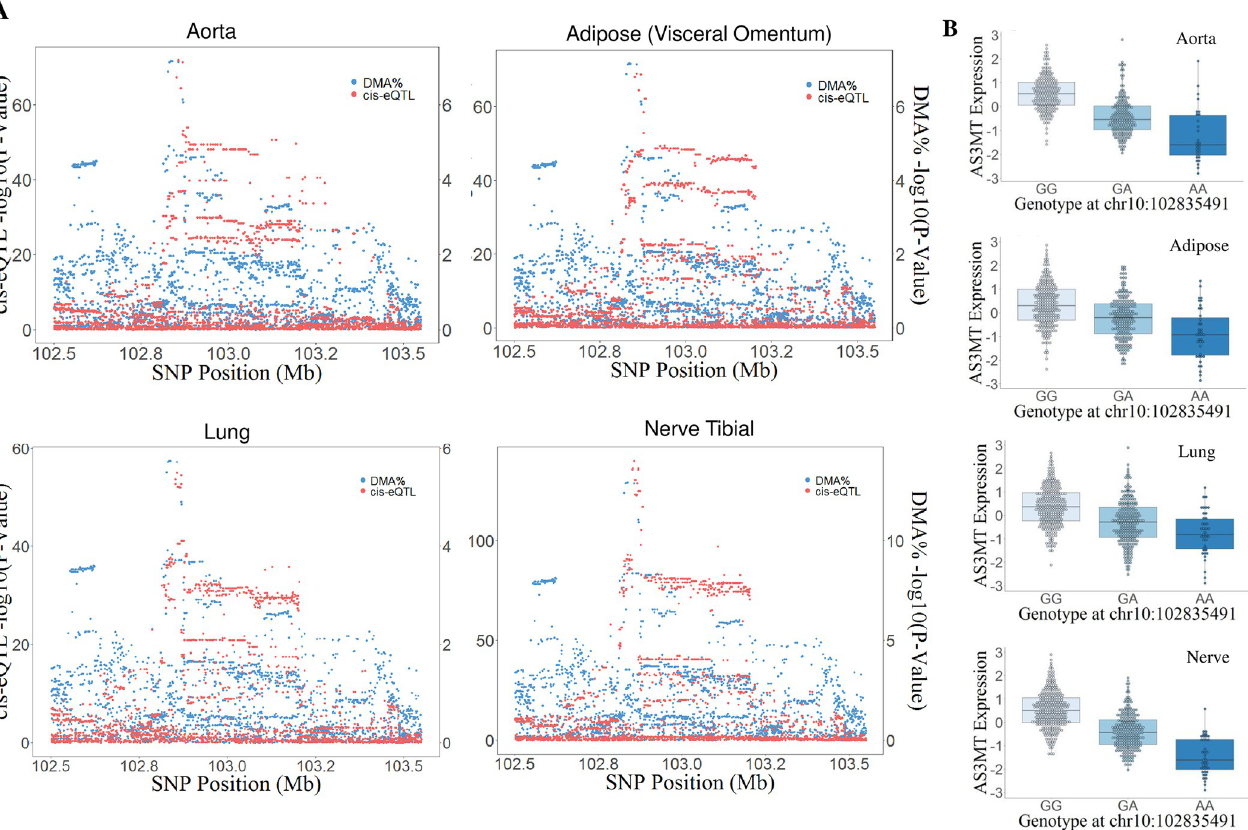
Fig 6. Co-localization between HEALS DMA% association signal (rs4919687) and AS3MT eQTLs in multiple tissues. We observe evidence of co- localization in 21 GTEx tissue types, with four example tissue types shown in Panel A (aorta, adipose-visceral omentum, lung, and nerve-tibial). The low efficiency (low DMA%) allele at rs4919687 is consistently associated with lower AS3MT expression in all tissues for which co-localization was observed.